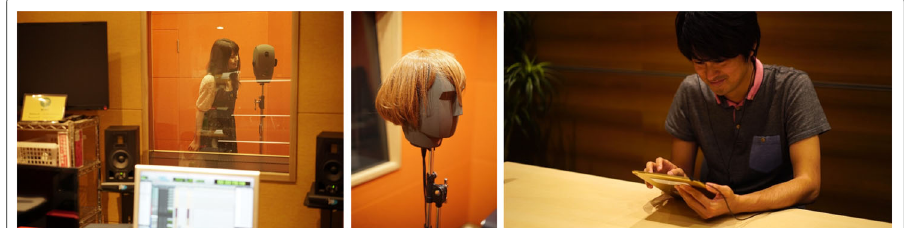
Fig. 1 Left: A voice actor is blowing into a dummy head microphone to express the meaning of the word “aerate,” which means “to introduce air into (something).” Center: For the word “rumple,” which means to mess up, for example, someone’s hair, a wig was attached to the dummy head microphone for representing a realistic experience. Right: A learner experiencing the meaning of “aerate” through the recorded voice using a general earphone and a